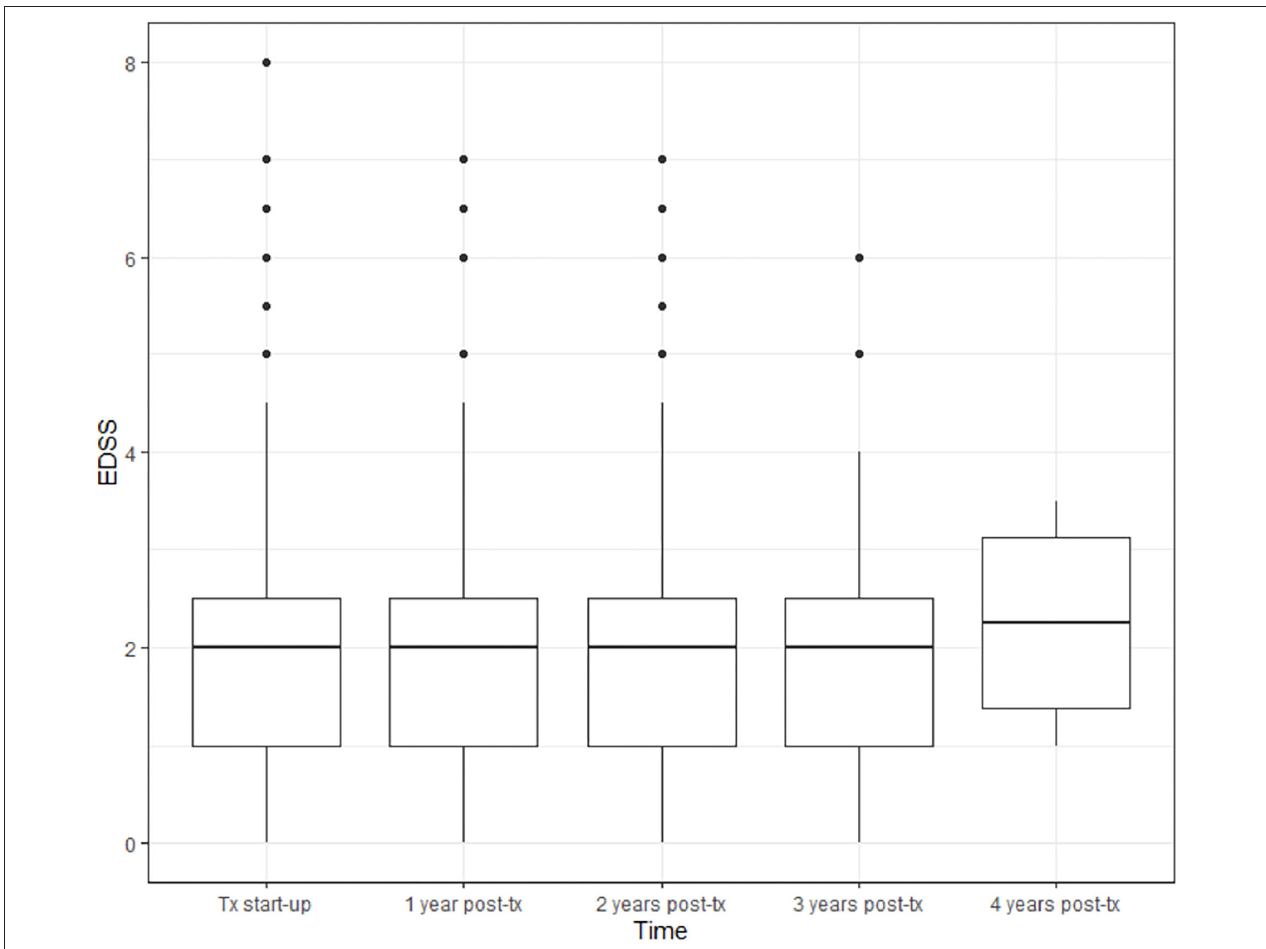
FIGURE 3 | Evolution of disability as measured by EDSS throughout follow-up. BOX, Interquartile range; Groos line, medias; Dots, Extrem values ( > 1.5 × interquartile range)